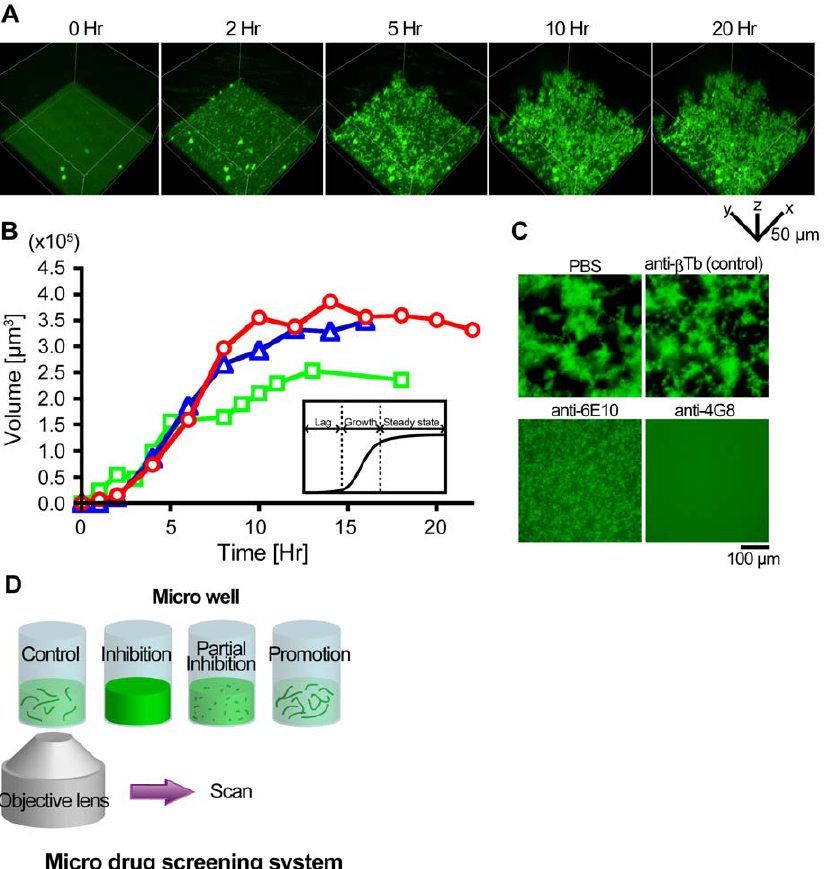
Figure 4. Imaging of A b aggregation invitro . (a) 4D imaging of A b aggregation. 0.1% QDA b (6)-containing A b 42 (final concentration 100 m M) were incubated in a 96-well glass bottom plate at 37 u C with controlled humidity and CO 2 concentration, and observed by confocal microscopy every 30 min over 20 h using a 488 nm excitation laser (20% power) and a 60x oil objective lens. (b) Time-course of A b aggregation. The volumes of A b aggregates measured from three 4D experiments (red, blue, and green). The total volume of the observed space is 1.9 6 10 6 m m 3 (138 6 138 6 100 m m). The inset shows an idealized kinetic curve for amyloid aggregation [29]. Amyloid aggregation consists of lag, growth, and steady state phases. (c) Inhibition of A b aggregation by anti-A b antibody. 0.1% QDA b (6)-containing A b 42 (final concentration 13 m M) were incubated in PBS with 0.6 m M control antibody (anti- b˜ tubulin, b Tb; top right), 0.6 m M anti-6E10 antibody (bottom left), and 0.6 m M anti-4G8 antibody (bottom right) in a 96-well glass bottom plate at 37 u C for 21 h, and observed by wide-field fluorescence microscopy. (d) The model of a micro drug screening